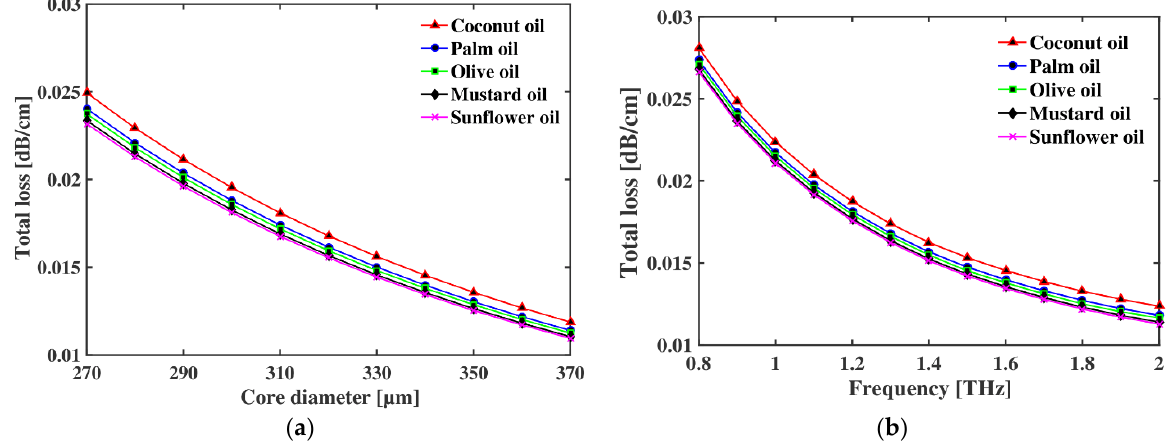
Figure 6. Total loss of the proposed oil detector for ( a ) different core diameters at 1.6 THz and ( b ) different values of frequencies at 340 µm core diameter.